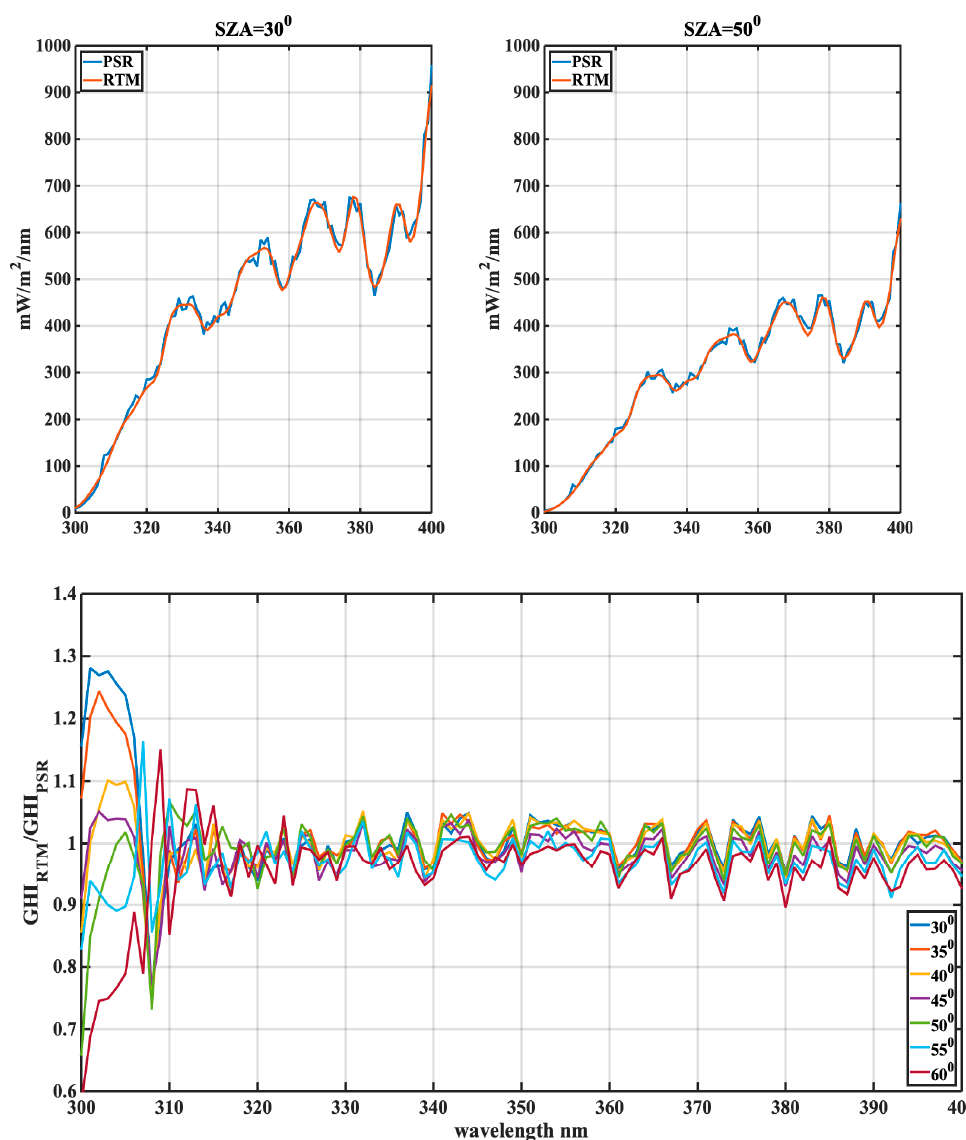
Figure 7. Upper plot modeled and measured with PSR GHI at SZA 30 ◦ and 50 ◦ . Lower plot, ratio of modeled to measured GHI, at seven different SZAs in the region 30 ◦ –60 ◦ . In Figure 8, modeled spectra at SZA of 30° and 60° are divided, from two separate RTM runs, using a constant climatological AOD (0.3) and different TOC, climatological (335 DU) and measured (292 DU as average for the 15th of May). At wavelengths higher than 330 nm, the ratio is constantly 1, where ozone has almost zero influence. At lower spectral regions, the ratio becomes ~1.5 at 305 nm and towards the lower wavelength regions, the ratios become higher exponentially. It is clear from this figure that the UVA region is prac- tically insensitive to TOC changes and UVB is highly sensitive and affects more the UVI. The average effect in the UVB region is a 32% increase in irradiance. This could lead to a 29% increase in the estimated UVI. The ratios depend on the SZA, as higher SZAs corre- spond to higher ozone attenuation.